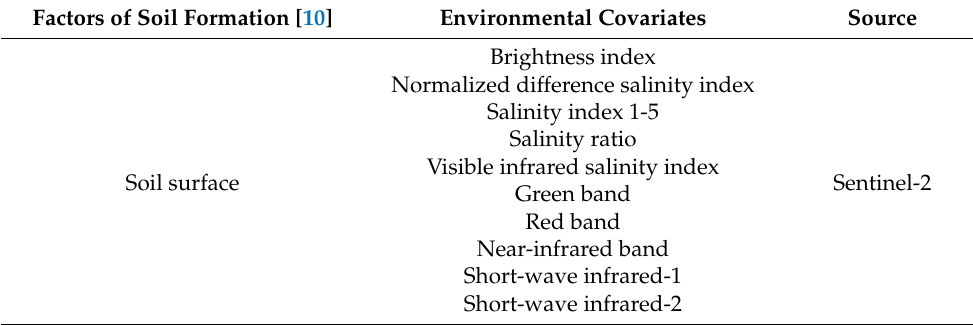
Table 1. Summary of environmental covariates used for spatial modelling. Factors of Soil Formation